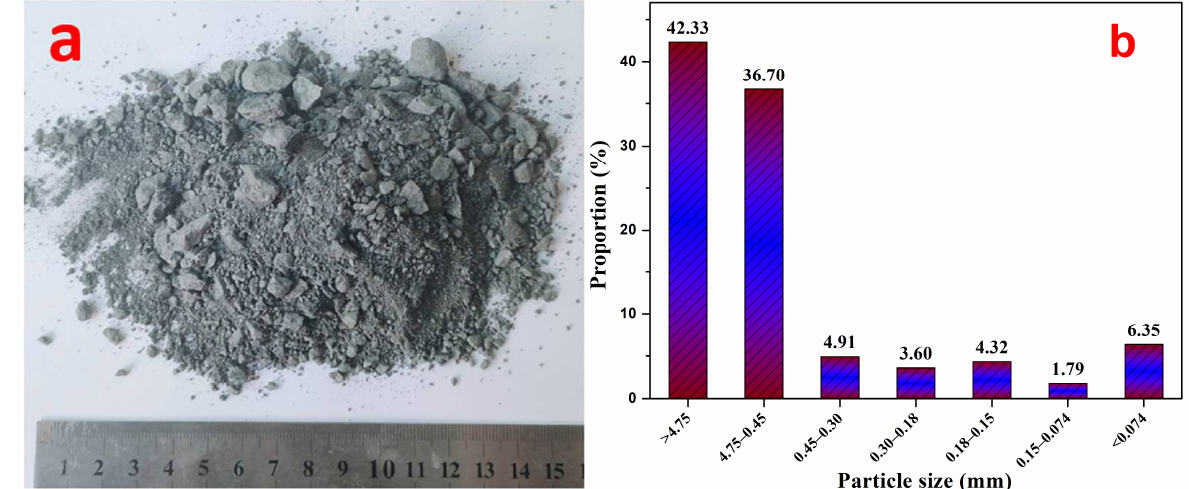
Figure 1. XRD results for different ore samples: ( a ) No. 1, ( b ) No. 3, ( c ) No. 5, and ( d ) No. 9.